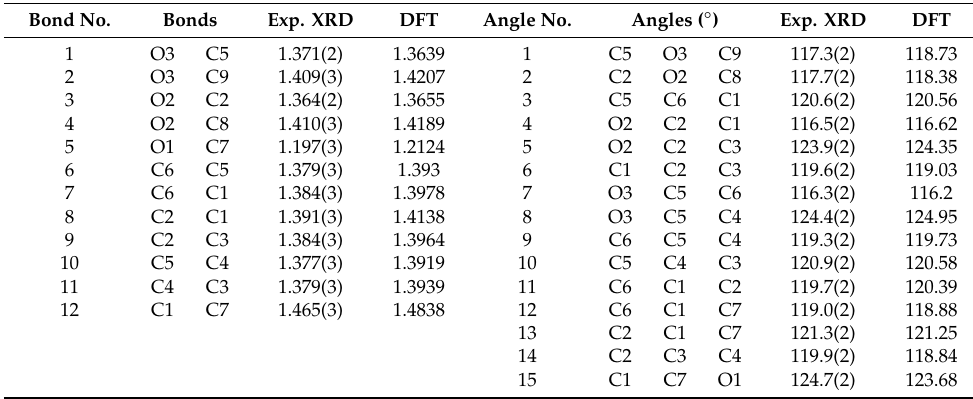
Table 2. Density functional theory (DFT)-calculated angles ( o ) and bond lengths (Å) compared to the corresponding X-ray diffraction (XRD) experimental results (exp. XRD).